Question: Condense the content of this figure into a single sentence.
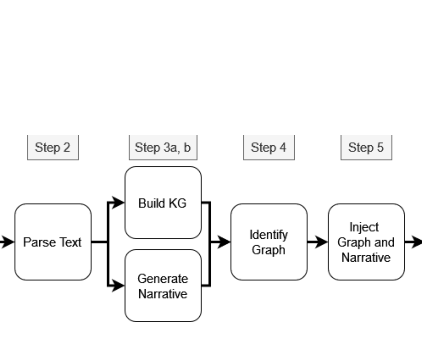
Answer: The steps of the GAME-KG Framework.